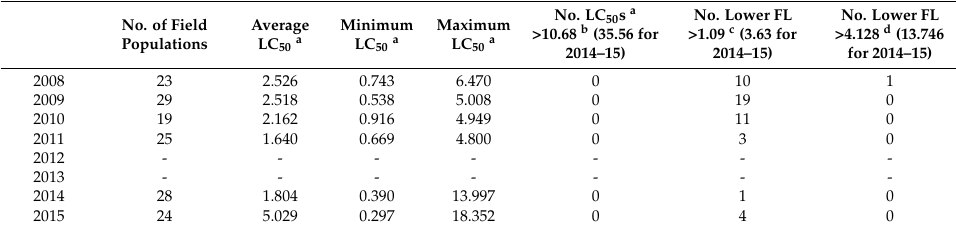
Table 5. Summary of annual responses of tarnished plant bug field population responses to imidacloprid.